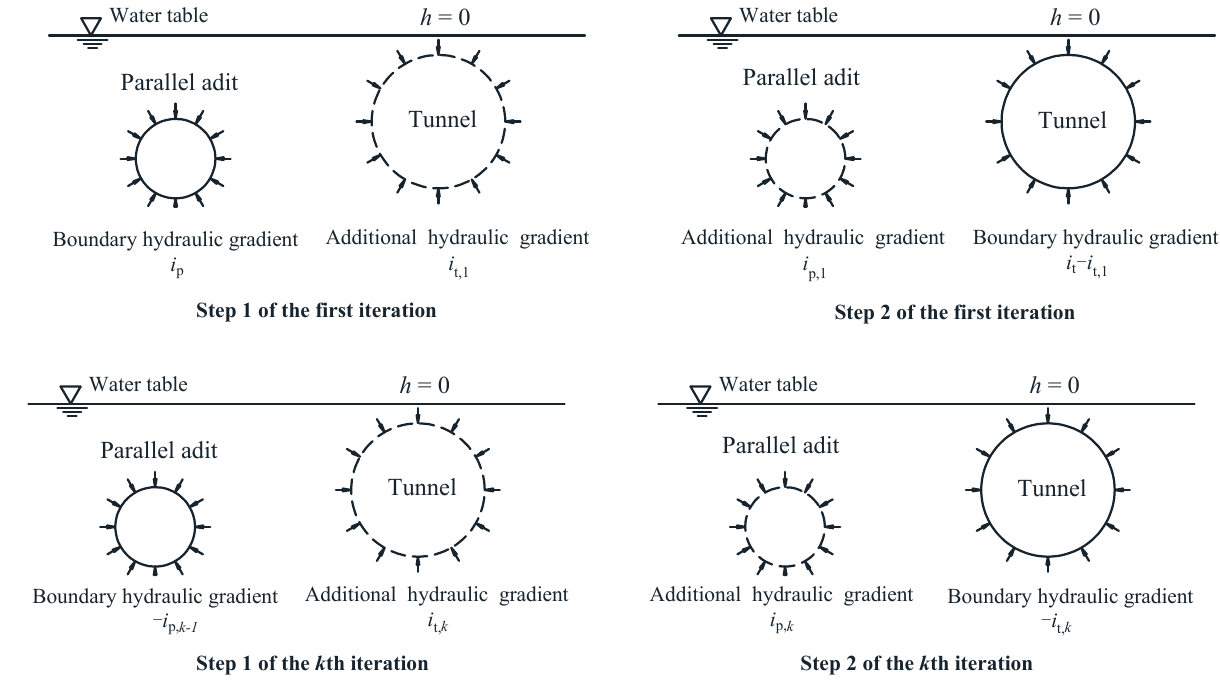
Figure 5. After each iteration, Equation (11) is used to determine if the iteration continues.